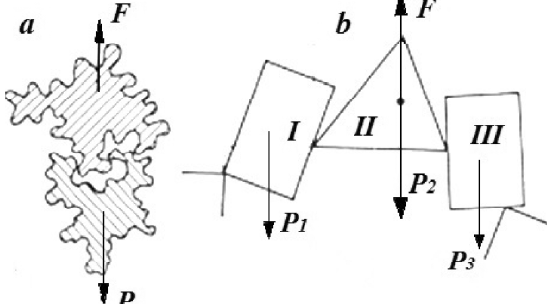
Fig. 5. The scheme of the action of mechanical forces: a- forces of mechanical engagement; b –the bear mechanical force (replotted regarding to the data from [1]).